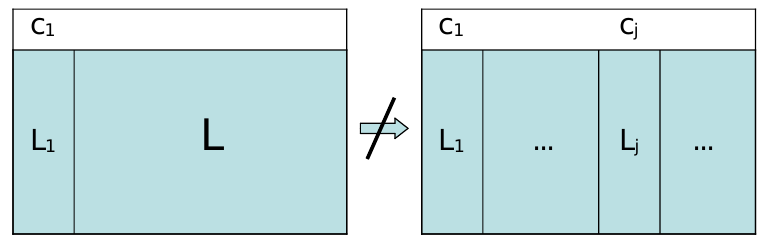
Figure 3 . Positivity forces c i ’s of the top row to align adjacently (in the cyclic